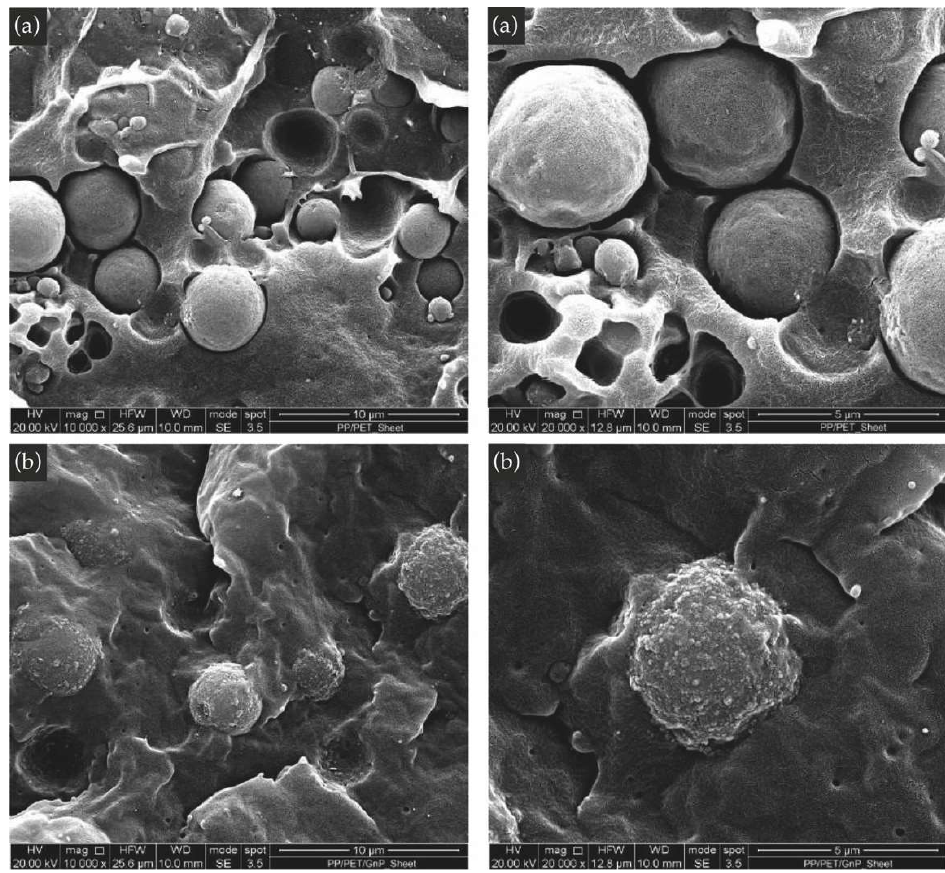
Figure 6. SEM micrograph of the blend ( a ) and of the nanocomposite ( b ) at different magnifica- tions.